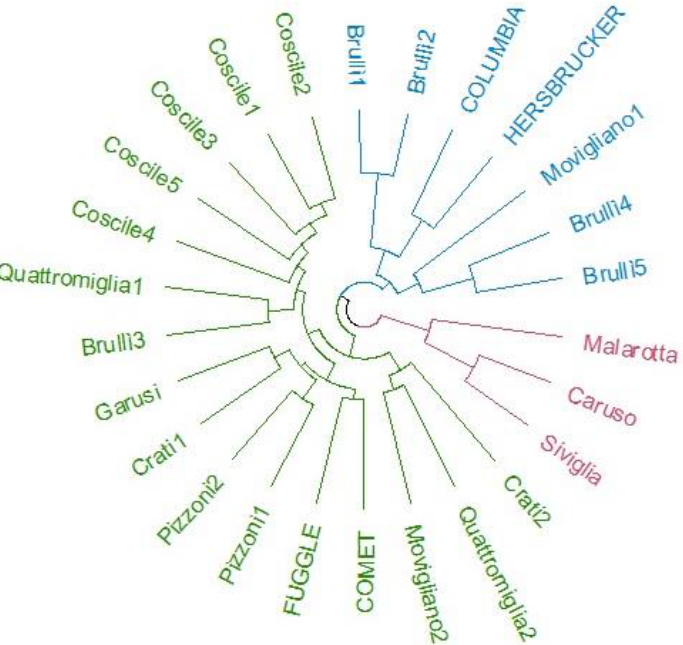
Figure 3. Unrooted dendrogram of the 22 Calabrian hops populations from three geographical areas and of four commercial varieties (Comet, Fuggle, Columbia, and Hersbrucker) based on eight SSR data points according to UPGMA method. The genotypes in red, blue, and green indicate three different clusters.